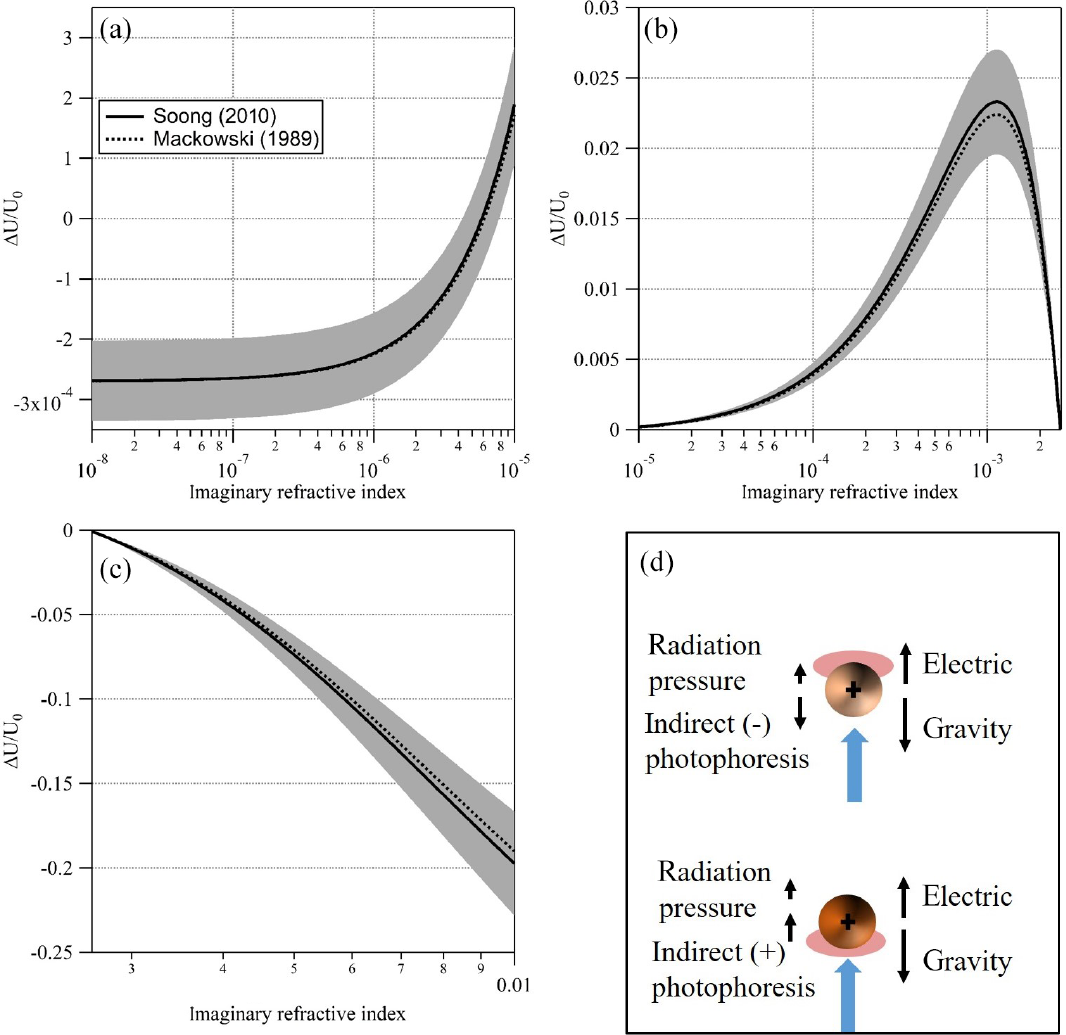
Figure 7. Simulated signal (and uncertainty) for a PEG400 particle, 10µm in radius at T = 20 ◦ C, P = 400mbar, n D = 1 . 466, λ = 473nm, and I = 35mWmm − 2 and full thermal accommodation with the increasing imaginary part of the CRI. (a) Transition from negligible ab- sorptivity and negative signal (i.e., dominated by radiation pressure) to positive signal (i.e., dominated by negative indirect photophoresis). (b) Increasing absorptivity leads to an increasing positive asymmetry parameter and stronger positive signal (i.e., negative indirect pho- tophoresis). Additional absorptivity leads to an asymmetry parameter of zero as the surfaces of the upper and lower hemispheres of the particle are effectively at equal temperature. (c) Additional increase in absorptivity leads to an increase in a negative asymmetry parameter and stronger positive indirect photophoresis. (d) An illustration of the positive and negative indirect photophoresis regimes. Black arrows represent the various forces acting on a “strongly” (lower) and “slightly” (upper) absorbing particle when illuminated with the laser beam (blue